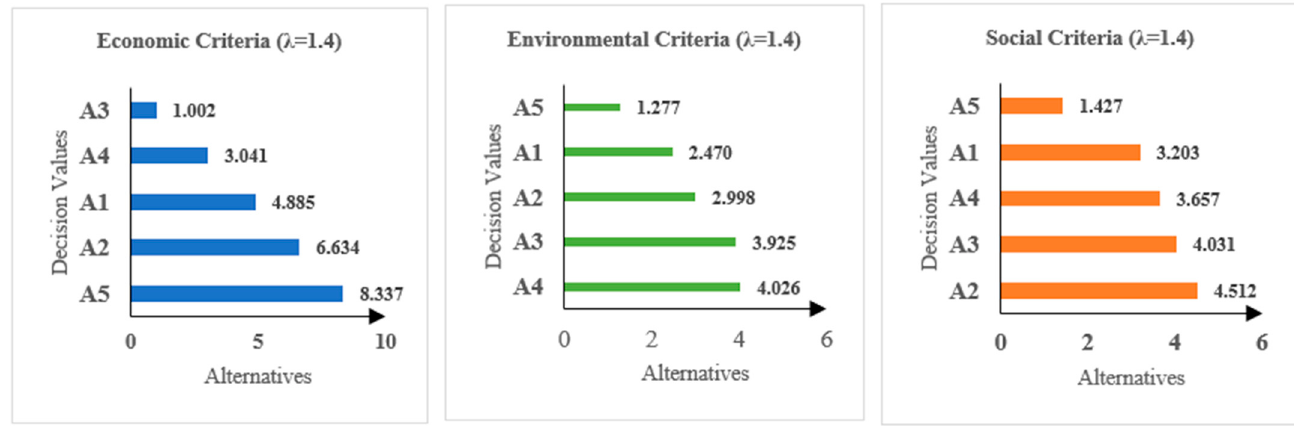
Figure 4. Results of the CoCoSo method for different aspects of sustainability.